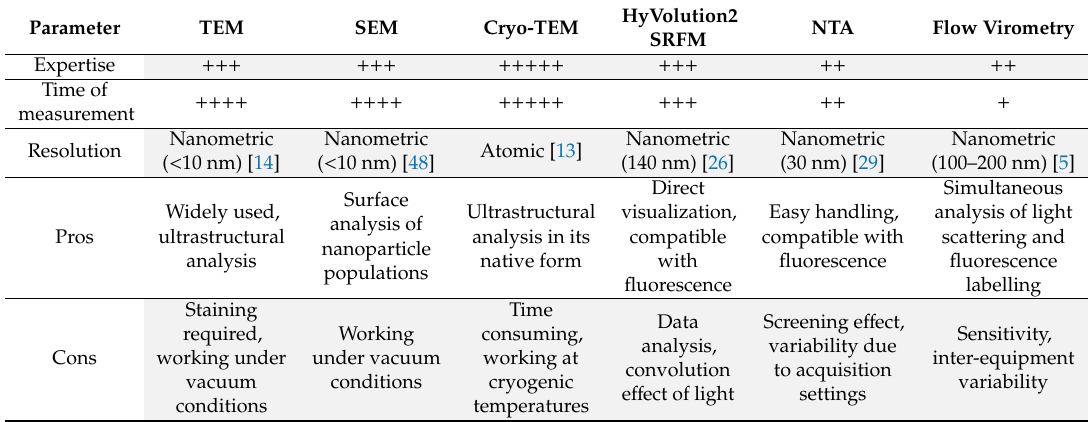
Table 3. Comparison of the di ff erent analytical technologies assessed in this